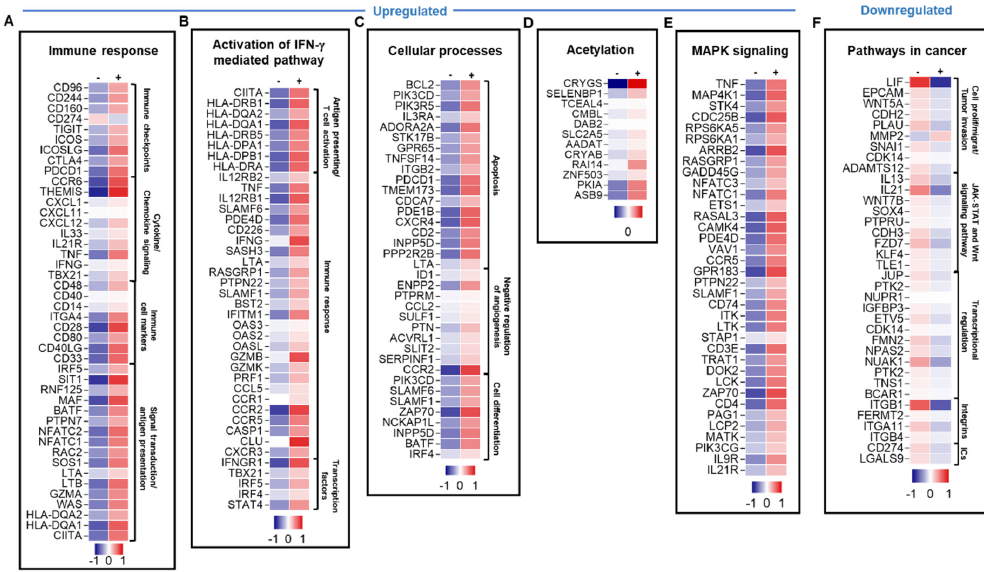
Figure 4. Differential gene expression of breast tumor-infiltrating immune cells in response to anti-TIM-3 mAb treatment. Heatmaps show the Z-score calculated from TPM of each gene to compare the expression level in tumor-infiltrating immune cells treated with anti-TIM-3 vs. non-treated cells. Each column represents a sample pooled from two explant cultures either treated or untreated, and each row represents the Z-score for mean expression obtained from two explant cultures (patients #57 and 59). The Z-score for mean expression level of each gene is depicted according to color scale. The functional categorization of top significantly upregulated and downregulated genes (with a fold change of >2 and p value <0.05 cutoffs) from CLC analysis were analyzed separately through the DAVID platform. Genes involved in immune response ( A ), the activation of the IFN- γ -mediated signaling pathway ( B ), cellular processes ( C ), MAPK signaling ( D ), and acetylation ( E ) were upregulated in response to anti-TIM-3, while genes in cancer-related pathways ( F ) were downregulated.